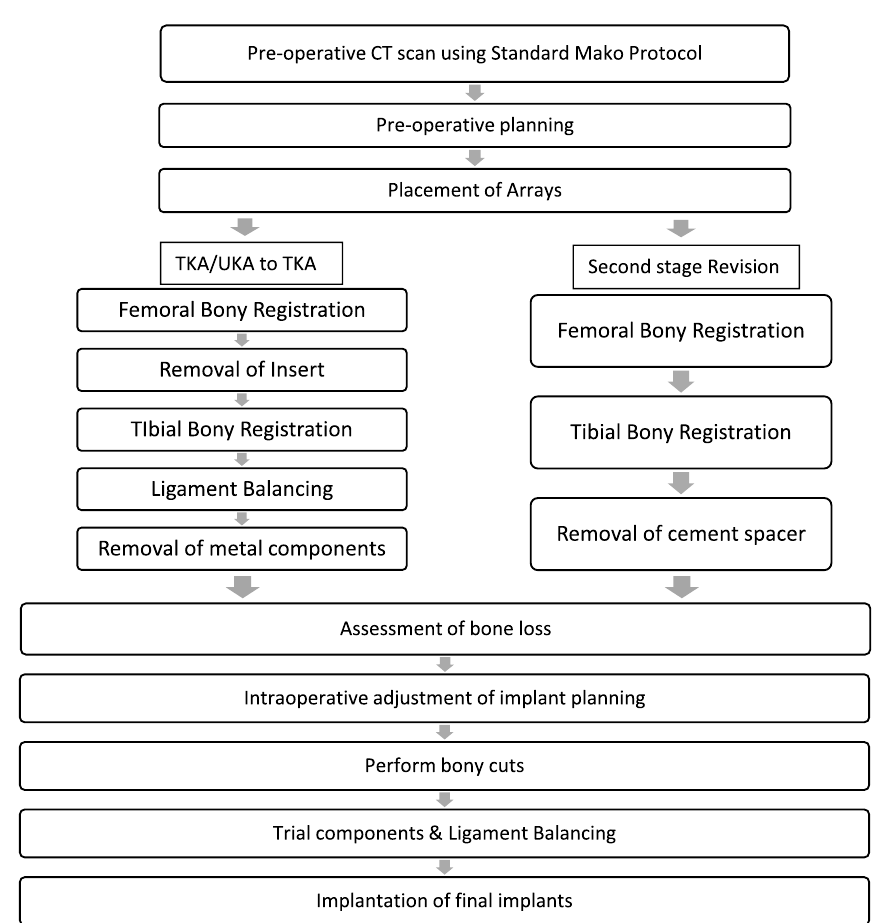
Fig. 16 Steps of surgical techniques for robotic‑assisted